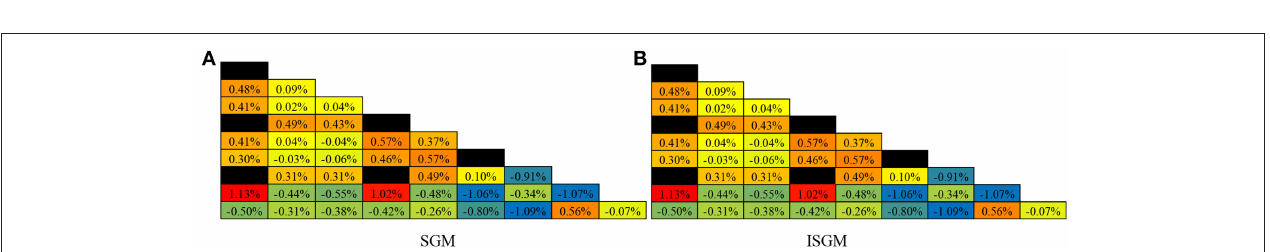
FIGURE 11 | Error distribution of normalized lattice pin power of UO2 assembly. (A) SGM, (B) ISGM.